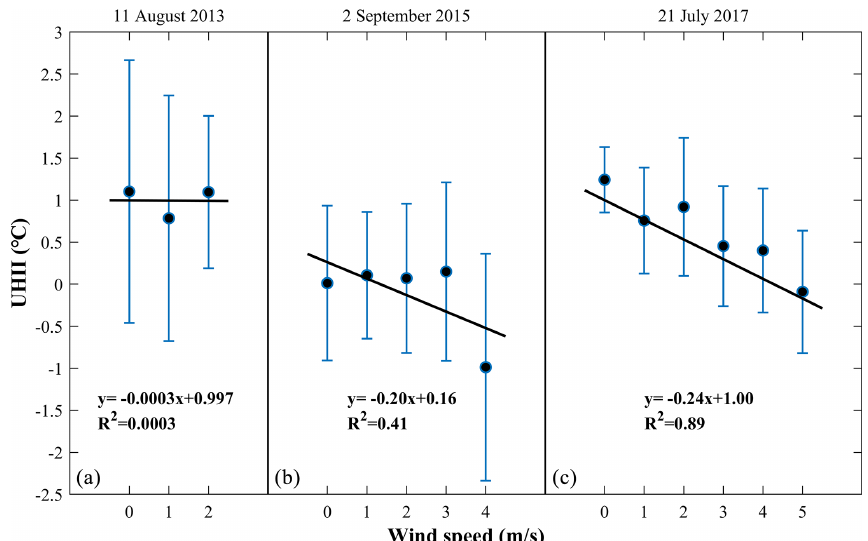
Figure 12. Relationship between CUHII and wind speed around all meteorological stations on (a) 11 August 2013, (b) 2 September 2015, and (c) 21 July 2017. The black dots represent the mean canopy UHII; error bars indicate the uncertainties of 1 standard deviation from the